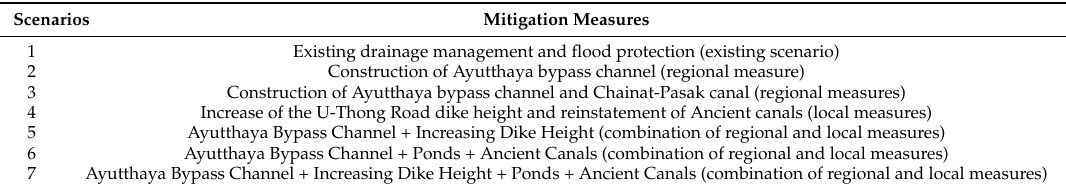
Figure 6. Illustration of the 1D/2D MIKEFLOOD model set up, which was used in the present work (the square shaded symbol represents the Ayutthaya region, which is the extent of the 2D model domain). The two circles, C.13 and RAMA VI denote upstream inflow points (i.e., upstream boundary conditions). The triangle FORT CHULA denotes the downstream tidal point at Fort Chula, Gulf of Thailand (i.e., downstream boundary condition). The horizontal and vertical axes show longitude and latitude positions. Table 1. Overview of key scenarios with different mitigation